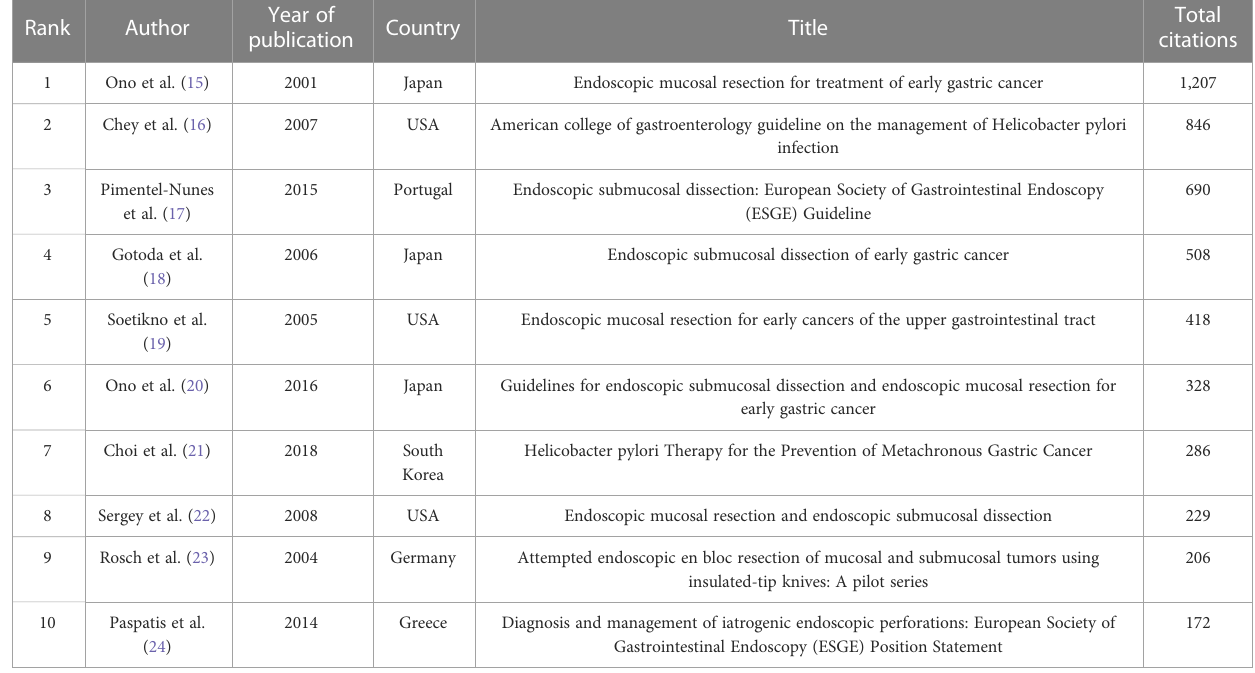
European countries, three Asian countries, and one North American country. These countries published 956 papers in total, representing 94.7% of the total number of publications. As shown in Figure 2B, three Asian countries (Japan, South Korea, and China) were highly productive, and they each published more than 100 papers separately over the past 20 years; the total number of publications from these three countries was 785, representing 77.8% of the total number of publications. Japan continued to be the leader in publications (452, 44.8%), followed by South Korea (183, 18.1%) and China (150, 14.9%). Japan also had the highest centrality among countries and institutions. The number of publications in China has generally increased in recent years as well.